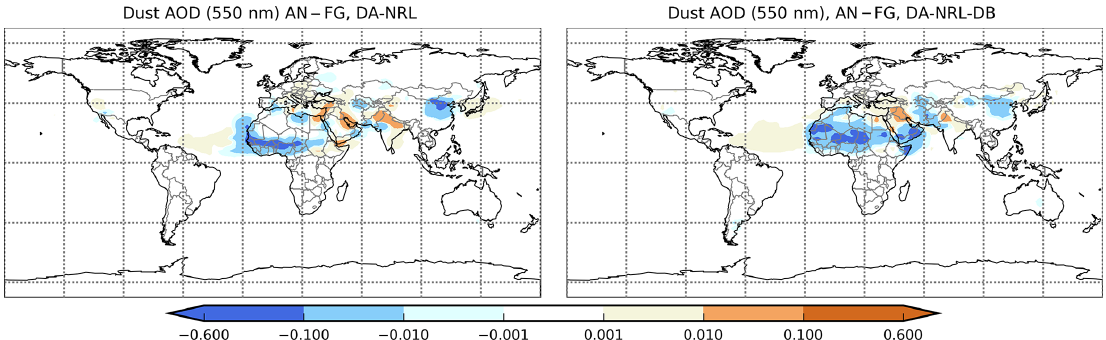
Figure 10. Mean dust AOD analysis increments for May to August 2007 at 12:00UTC for the DA-NRL experiment (left) and for the DA-NRL-DB experiment